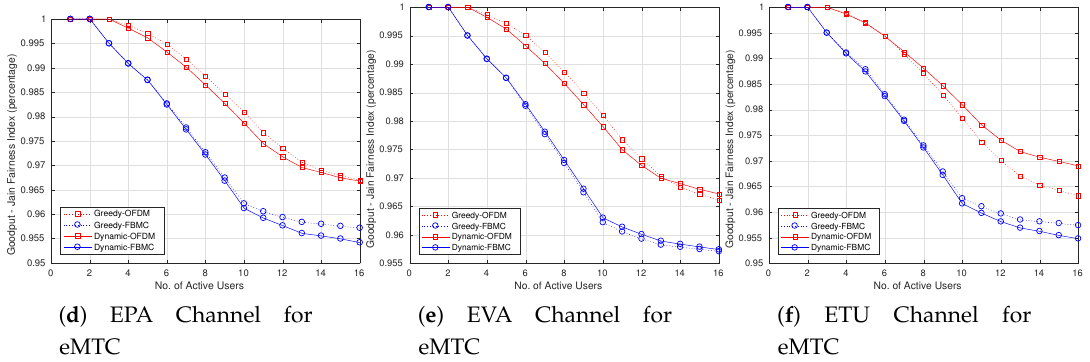
Figure 5. Goodput Jain Fairness Index for the greedy and dynamic approaches.